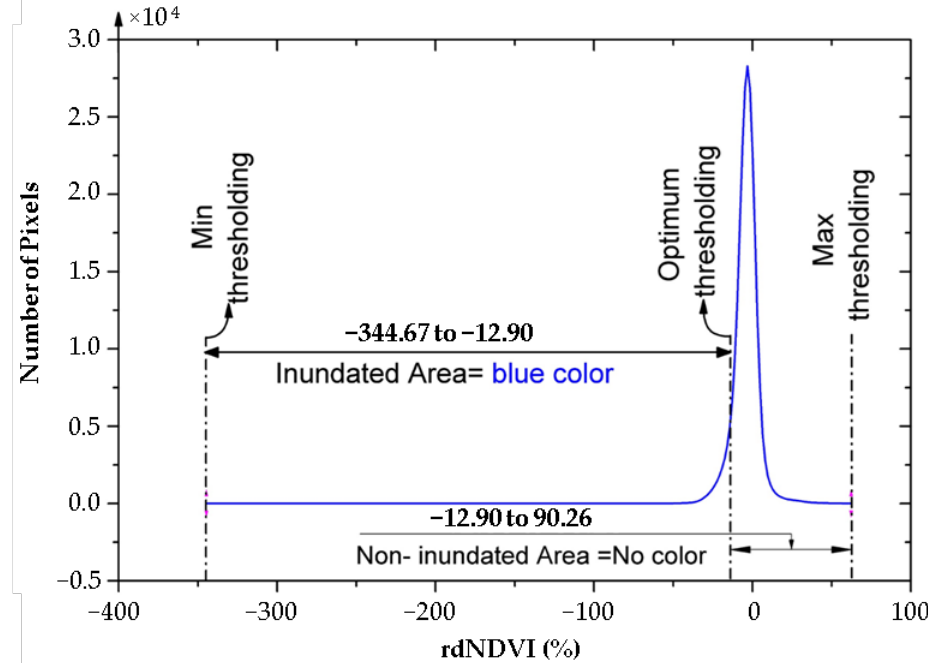
Figure 13. Histogram of the rdNDVI image with the chosen thresholds.